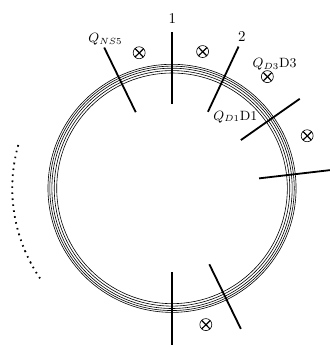
Figure 3 . Circular quiver describing longitudinal M5-branes with momentum charge probing an ALE